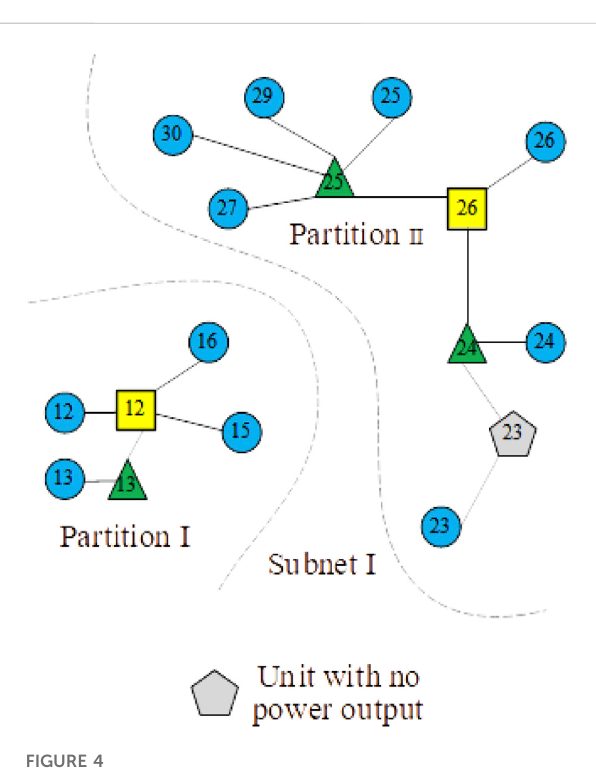
FIGURE 4 Group diagram and partition diagram of subnet Ⅰ